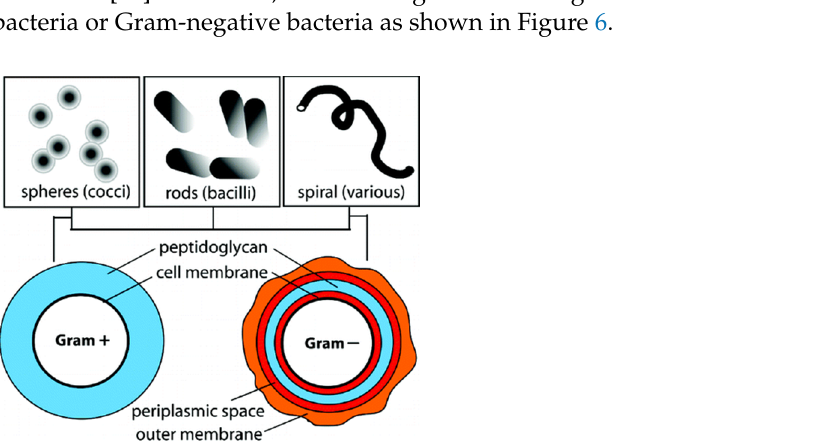
Figure 6. Bacteria are classified by shape and then by the outermost cell envelope composition as designated by a Gram-stain [26] . Reprinted with permission from ref. [26] . © 2009 American Chemical Society.